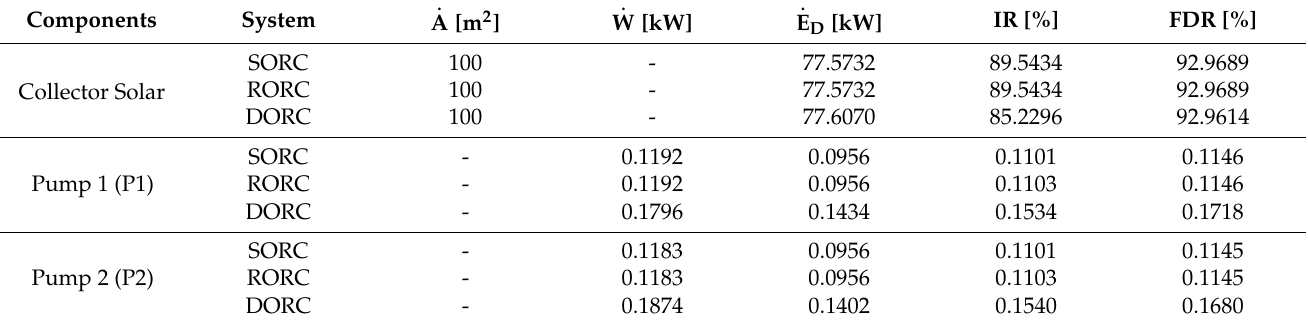
Table 6. Exergy analysis of the systems based on SORC, RORC, or